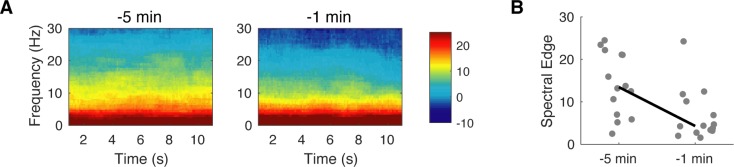
Spectral properties preceding a discontinuity event.(A) Group median spectrogram of children 4 months and older (n = 14) within five minutes and within one-minute preceding first discontinuity. (B) Spectral edge decreases within a five-minute to one-minute window preceding discontinuity (Wilcoxon Sign-Rank, p < .005). Line represents median.